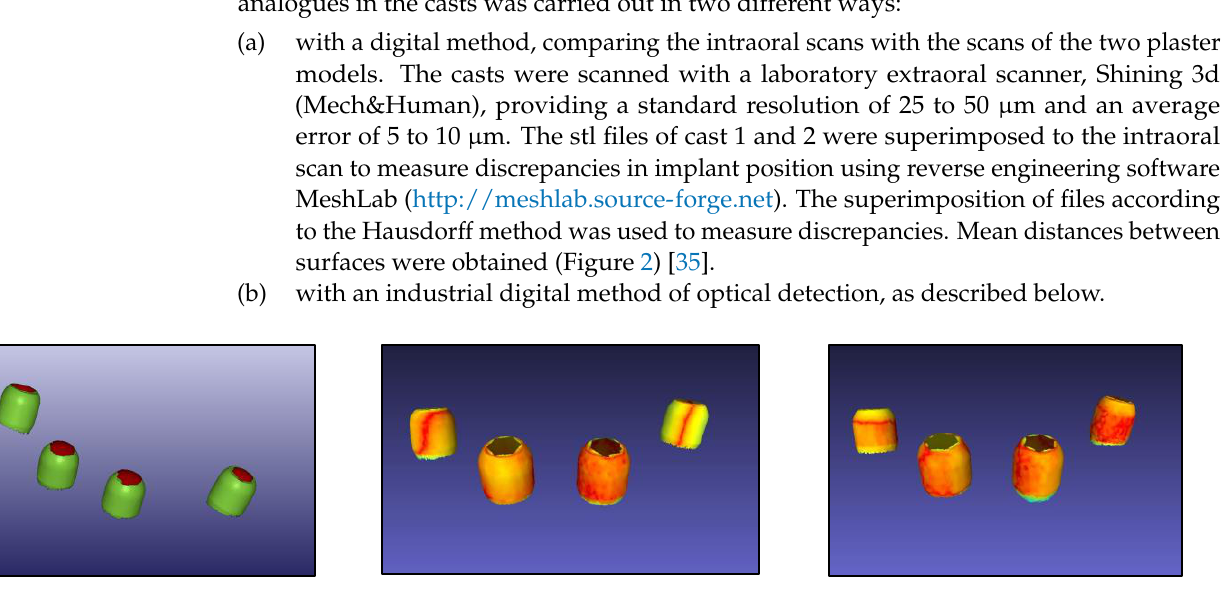
Figure 2. ( Left — intraoral scan; Centre — superimposition of the intraoral scan with the scan of cast Figure 2. ( Left —intraoral scan; Center —superimposition of the intraoral scan with the scan of cast 1; 1; Right — superimposition of the intraoral scan with the scan of cast 2. Right —superimposition of the intraoral scan with the scan of cast